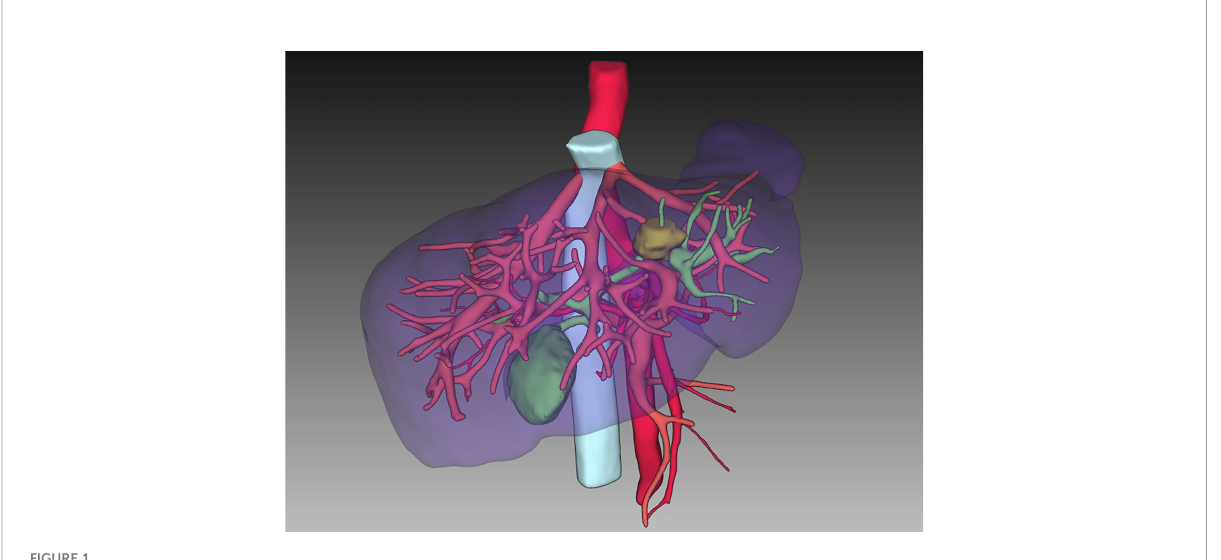
FIGURE 1 The preoperative 3D-restruction of